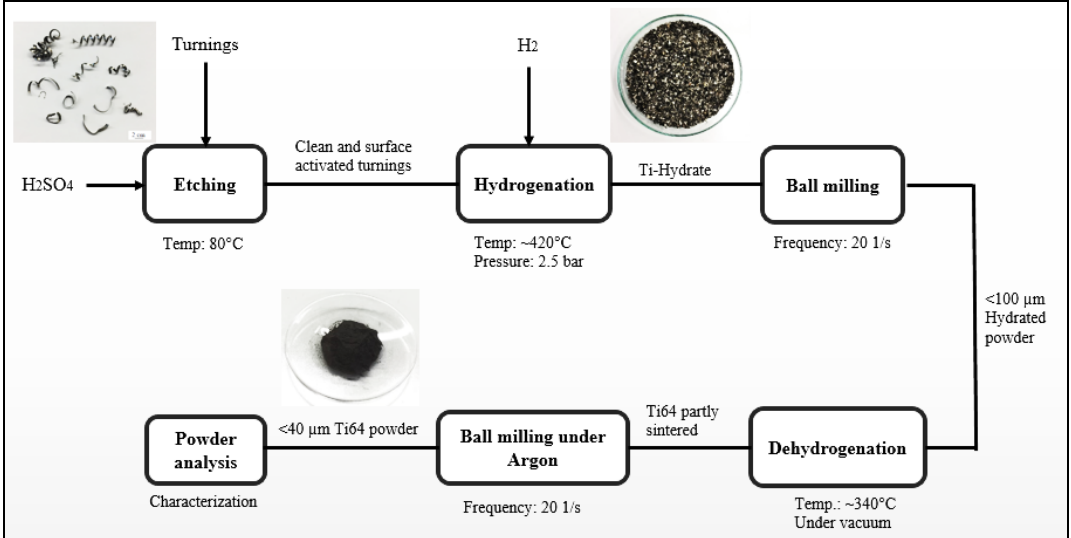
Figure 1. Experimental procedure of powder production via the HDH process.